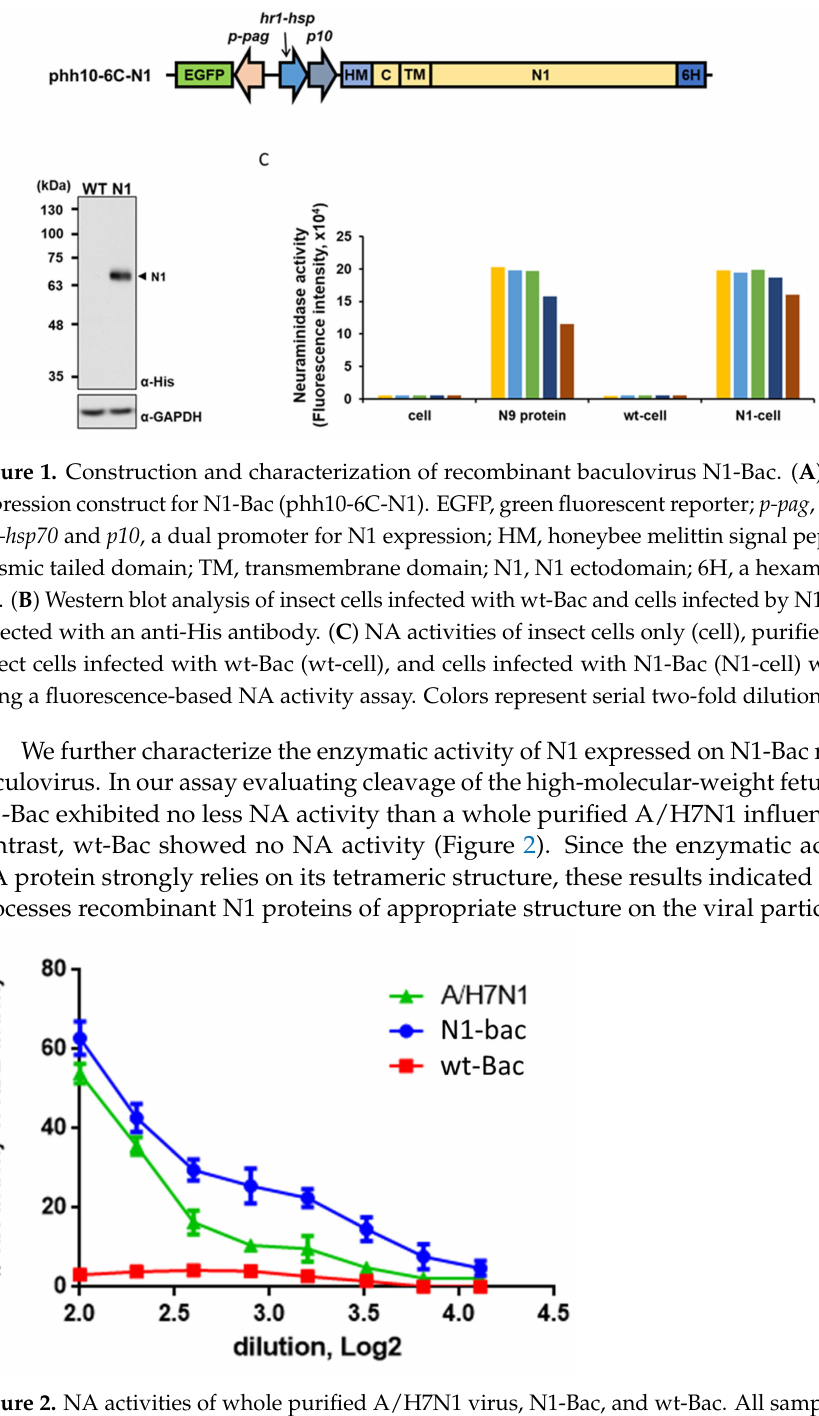
Figure 2. NA activities of whole purified A/H7N1 virus, N1-Bac, and wt-Bac. All samples were two- fold serially diluted and added to plates coated with 50 µ g/mL of fetuin substrate. After incubation at 37 ◦ C for 1 h, the fluorescing products generated upon NA digestion were measured using an excitation wavelength of 365 nm and an emission wavelength of 450